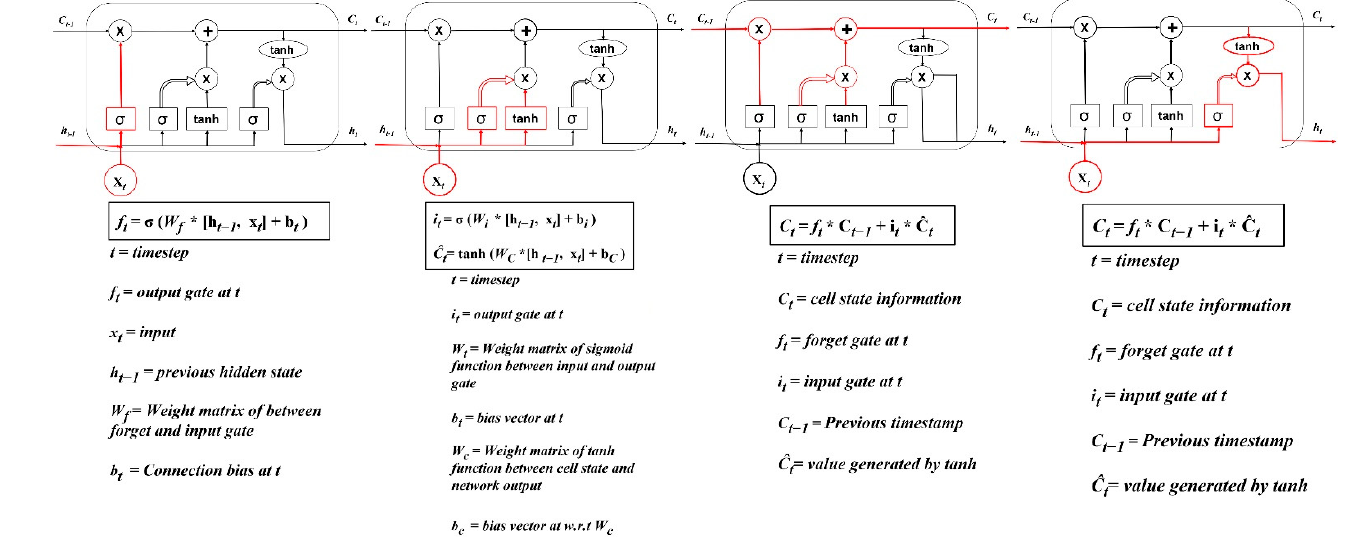
Figure 6. LSTM cells with gates (forget, input, cell, and output) show the flow of information. Table 2. All cell and gate operations are presented in the following equations for all the gates and cells.